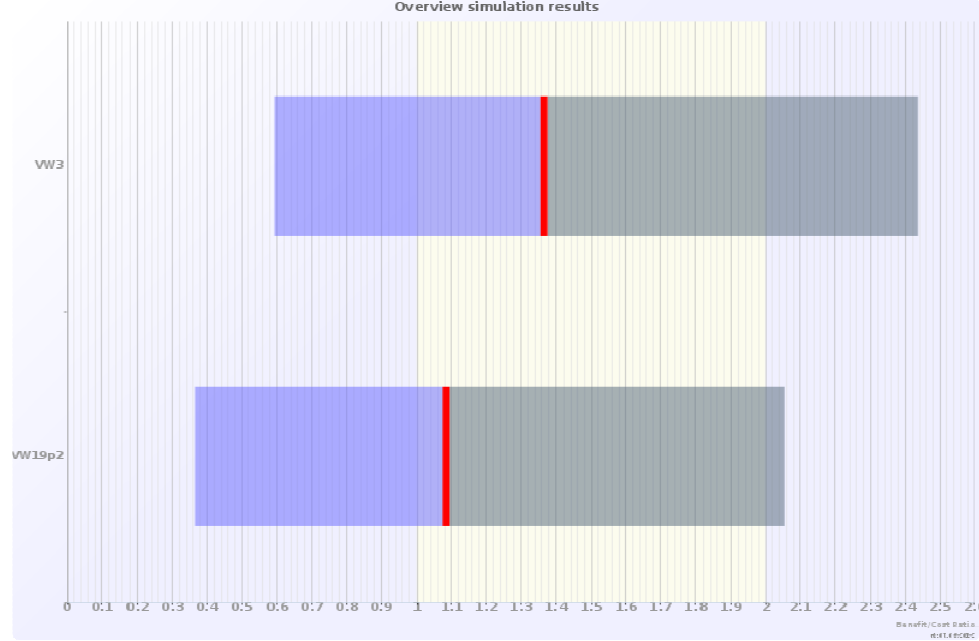
Figure 4. Monte Carlo simulations of benefit-cost (B/C) ratios, for the two demonstration projects with differently sized green walls—3 m high and 19.2 m high, assuming a green wall unit price of 0.5 EUR (2010) per m 2 per person per